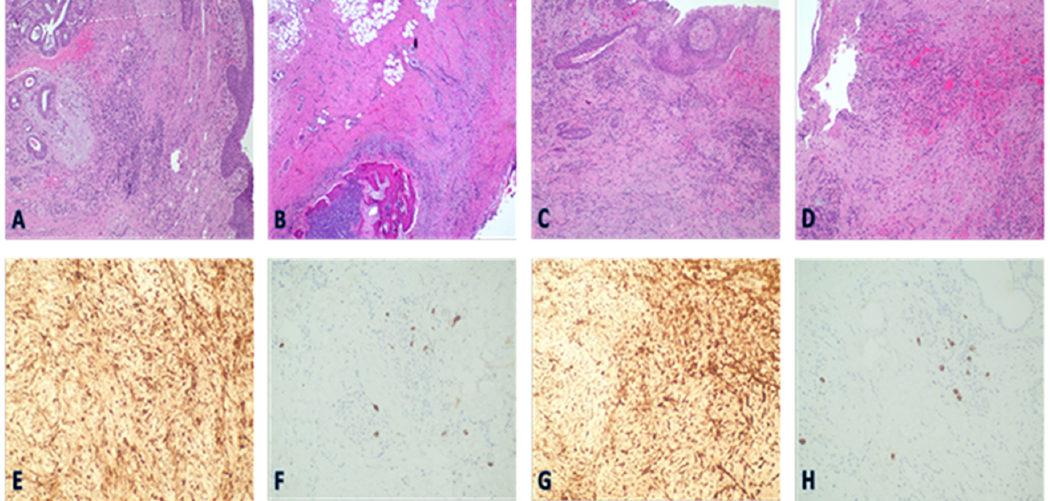
Figure 5. Histological section of the trachea with fibrosis and plasma cell infiltration (hematoxylin-eosin; ×20 magnification). Upper row: Representative histological micrographs comparing the lateral part of subglottic tracheal stenosis between a patient with post-COVID stenosis ( A , B ) and a patient with non-COVID stenosis ( C , D ) (hematoxylin-eosin staining; × 20 magnification). The findings are similar. ( A ). Squamous metaplasia, thickening, and scarring of submucosa, considerable interstitial fibrosis. ( B ). Submucosal vessels dilatation, hyperemia, and granulation tissue proliferate. ( C , D ). Degeneration and ischemic necrosis of the cartilaginous tracheal rings. Lower row: on immuno- histochemistry, plasma cells are mainly IgG-secreting elements, with a low tissue density of IgG4 subclass (IHC × 20 objective). The findings are similar between post-COVID ( E , F ) and non-COVID patients ( G , H ). Immunohistochemical stains show abundant IgG+ plasma cells, some of which are also IgG4+. The IgG4+ plasma cells exhibit a patchy distribution (IgG4, immunoperoxidase, original magnification × 200). A definite histopathologic diagnosis of IgG4-RD is not proven. Abbreviation: IgG, IgG4, immunoglobulin G and immunoglobulin